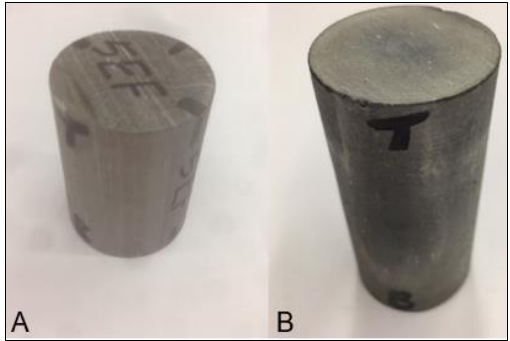
Figure 1. ( A ) Core plug from Eagle Ford outcrop; and ( B ) real core plug from shale formation at Anderson County, Texas.